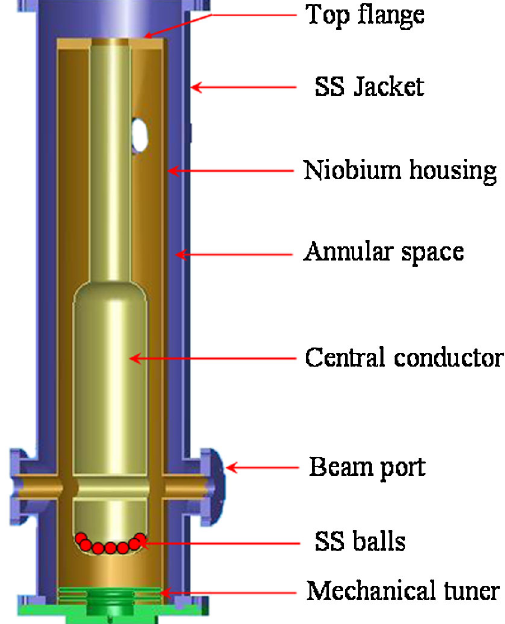
FIG. 9. (Color) Cross-sectional view of a resonator along with a few SS